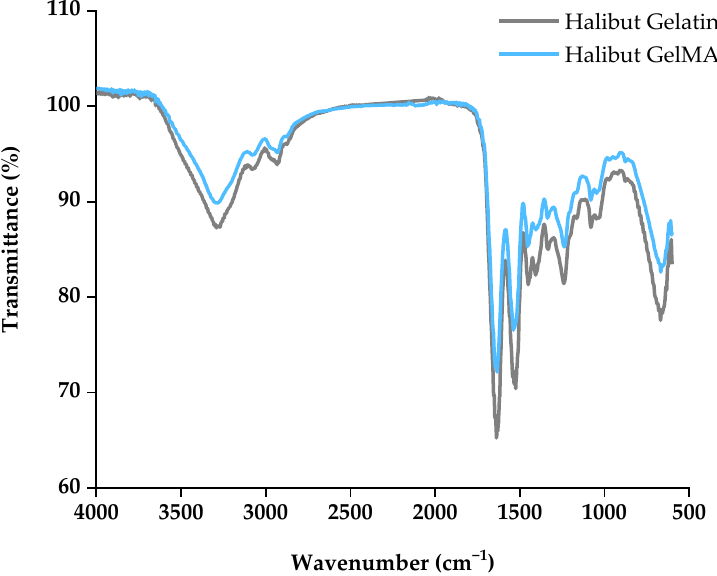
Figure 2. FTIR spectra of Greenland halibut gelatin (gray line) and derived GelMA (light blue line). FTIR analysis was also performed with GelMA samples (Figure 2, light blue line).